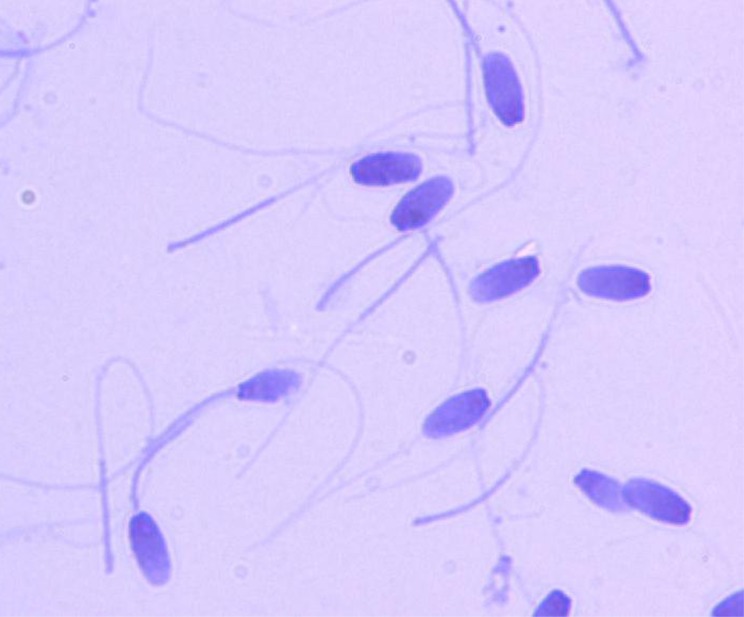
Microscopic image of stained elephant spermatozoa 8.5 months after the first GnRH vaccination (= 3 injections: Primer, 1st and 2nd booster), showing the example of tail and head separation, stain: SpermBlue®, magnification: x1000.